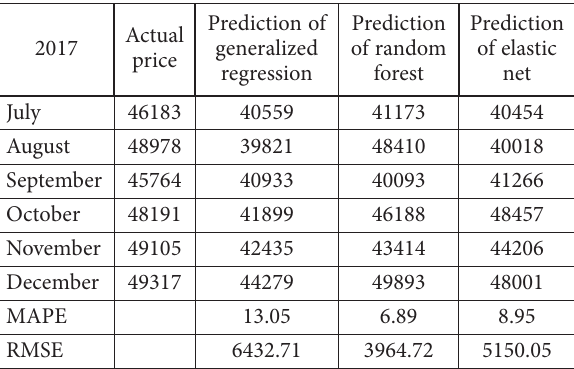
Table 8. Prediction performance of the three